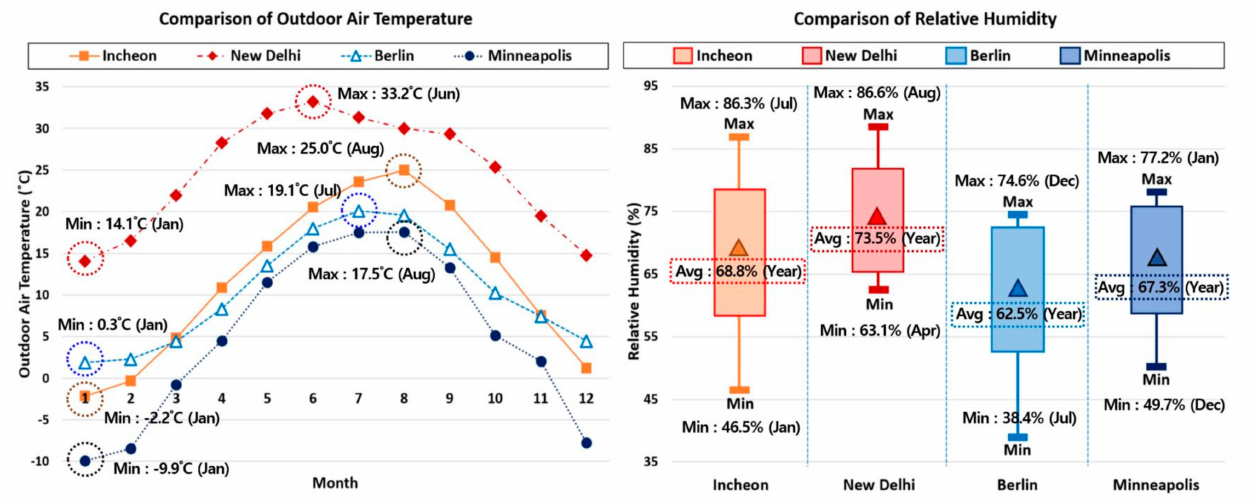
Figure 8. Climate characteristics of the four regions (average monthly outdoor air temperature and relative